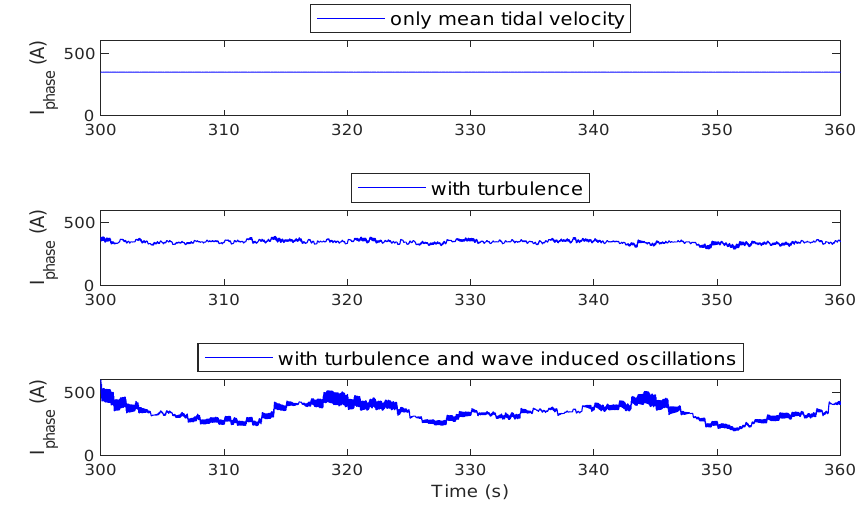
Figure 16. Generator phase currents (RMS